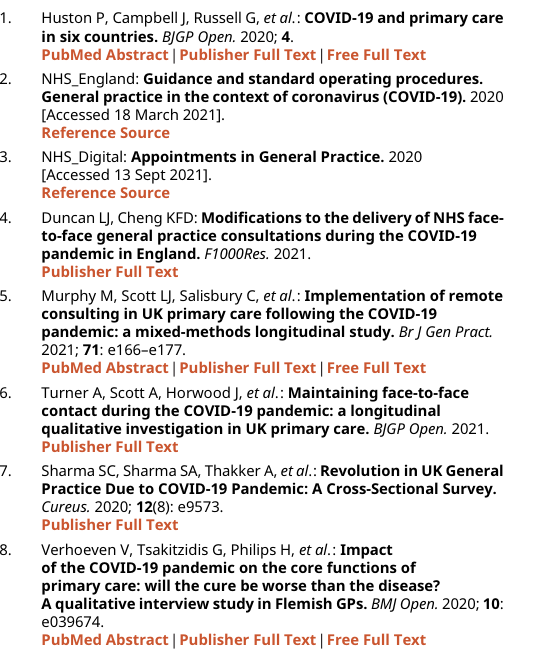
Figshare: Survey A questions, https://doi.org/10.6084/m9.figshare.14269469.v1 14